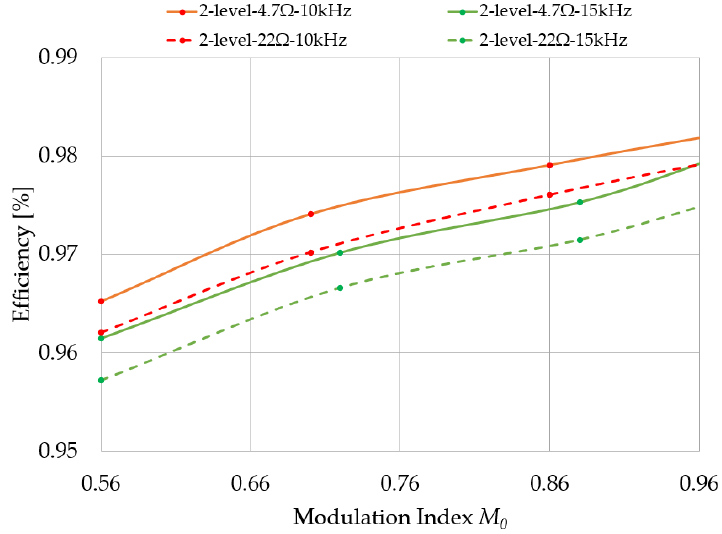
Figure 13. Efficiency of the three-phase 2L inverter as a function of modulation depth M 0 with l C =